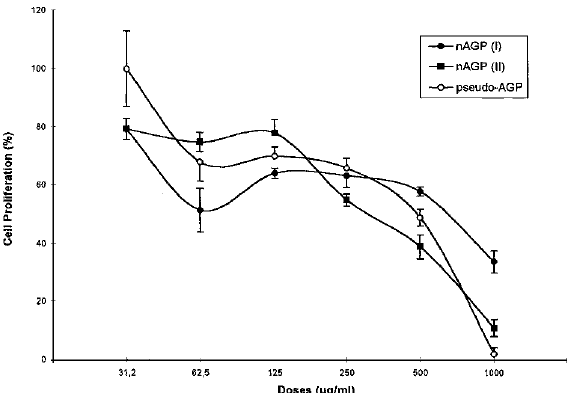
FIG. 1. Inhibition of PHA-induced lymphocyte proliferation with natural AGP (nAGP) and pseudo-AGP (see text). Periph- eral blood mononuclear cells were stimulated with optimum PHA dose and incubated for 72h in the presence of different concentrations of nAGP or pseudo-AGP.